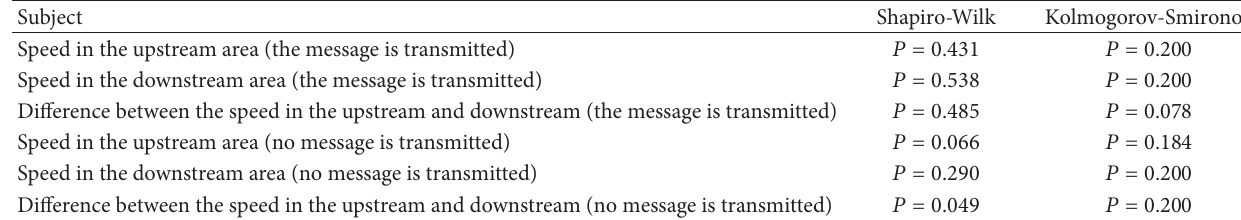
Table 6: Test results of analyzing data normalization.